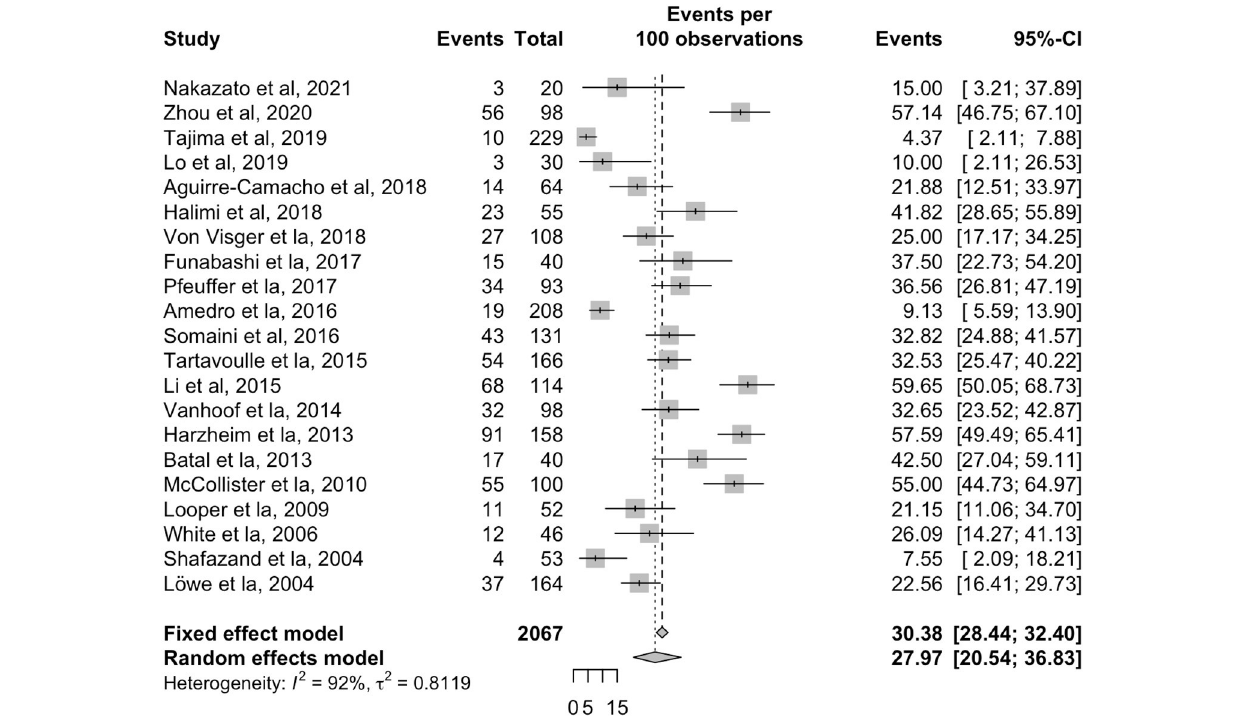
FIGURE 2 | Forest plot for the pooled prevalence of depression in patients with pulmonary